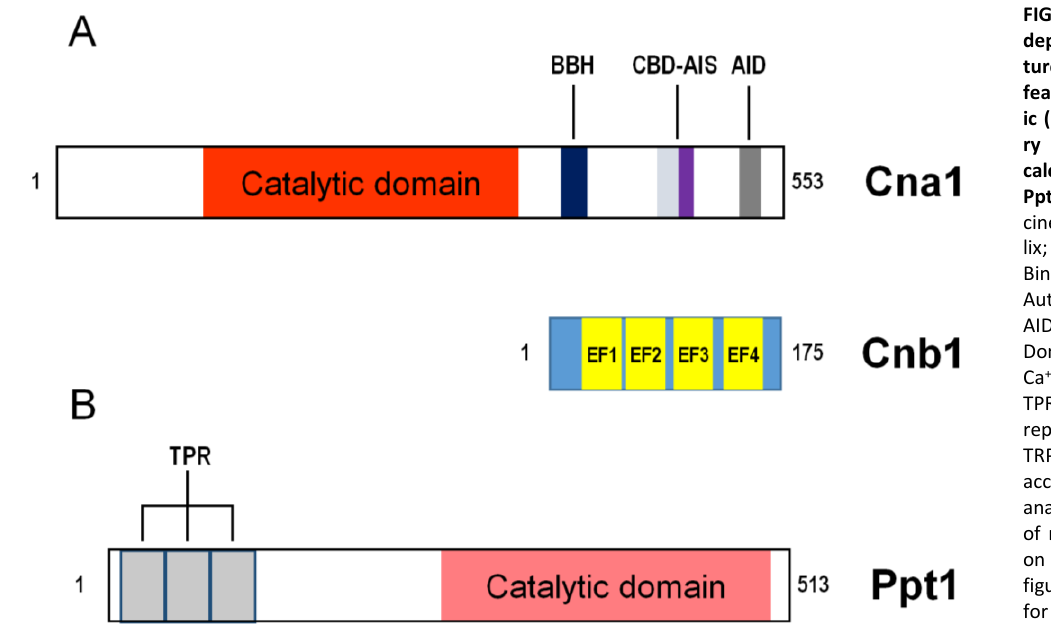
FIGURE 11: Schematic depiction of the struc- ture and functional features of the